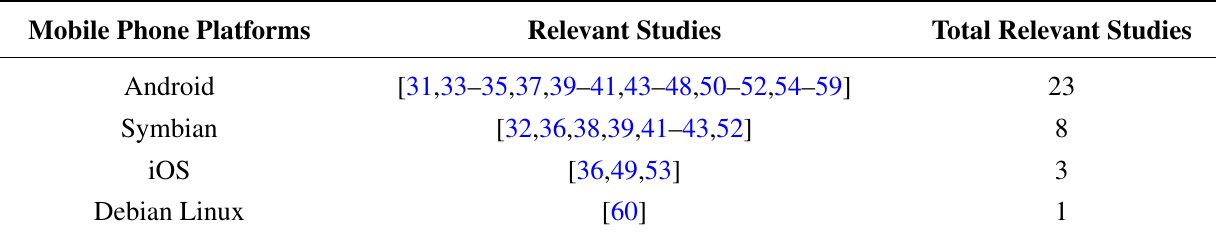
Table 4. Mobile phone platforms used for online activity recognition.